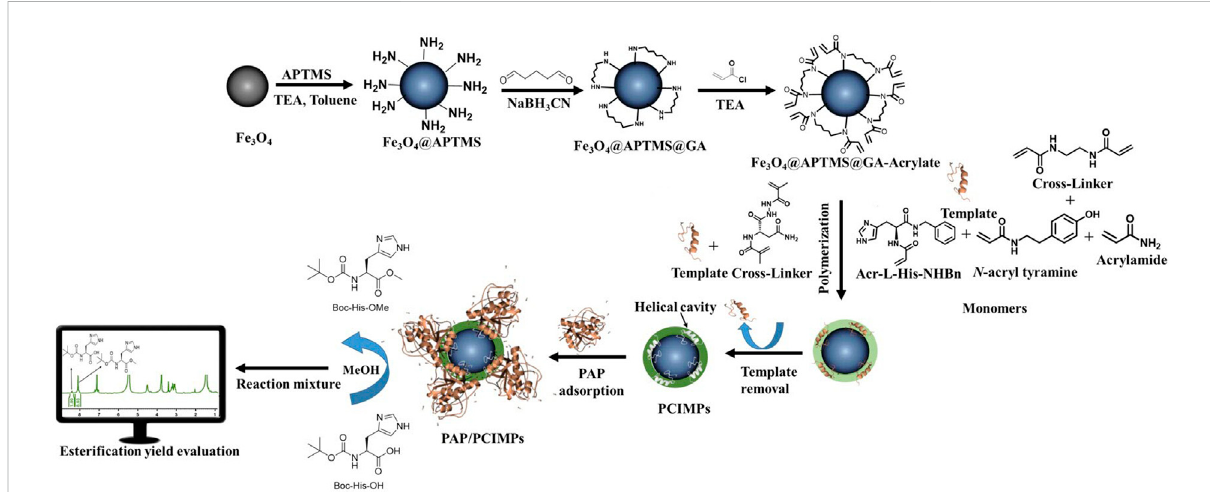
FIGURE 1 Schematicdiagramofthe(Top)fabricationofMPstoPCIMPsusingcross-linker,monomers,andtemplate(Bottom)applicationofPCIMPsusing their binding mechanisms toward PAP and PAP/PCIMPs catalyzed esteri fi cation and yield evaluation under the monitor. APTMS, 3-aminopropyl trimethoxysilane; TEA, trimethylamine; GA, glutaraldehyde; MPs, magnetic particles; PAP, papain; PCIs, peptide conformational imprints; PCIMPs, peptide conformational imprint magnetic